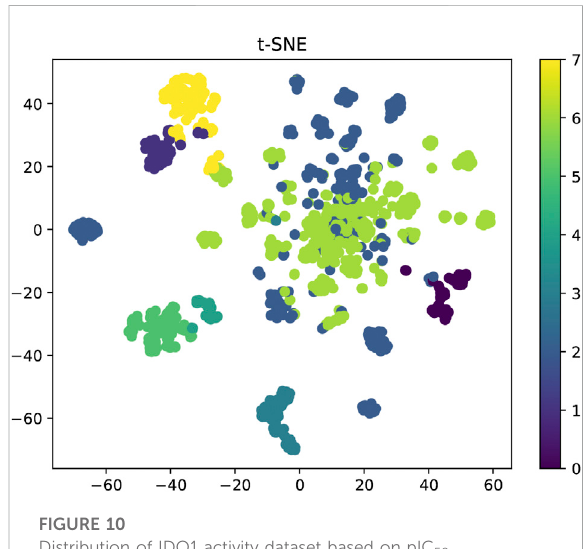
FIGURE 10 Distribution of IDO1 activity dataset based on pIC 50 .